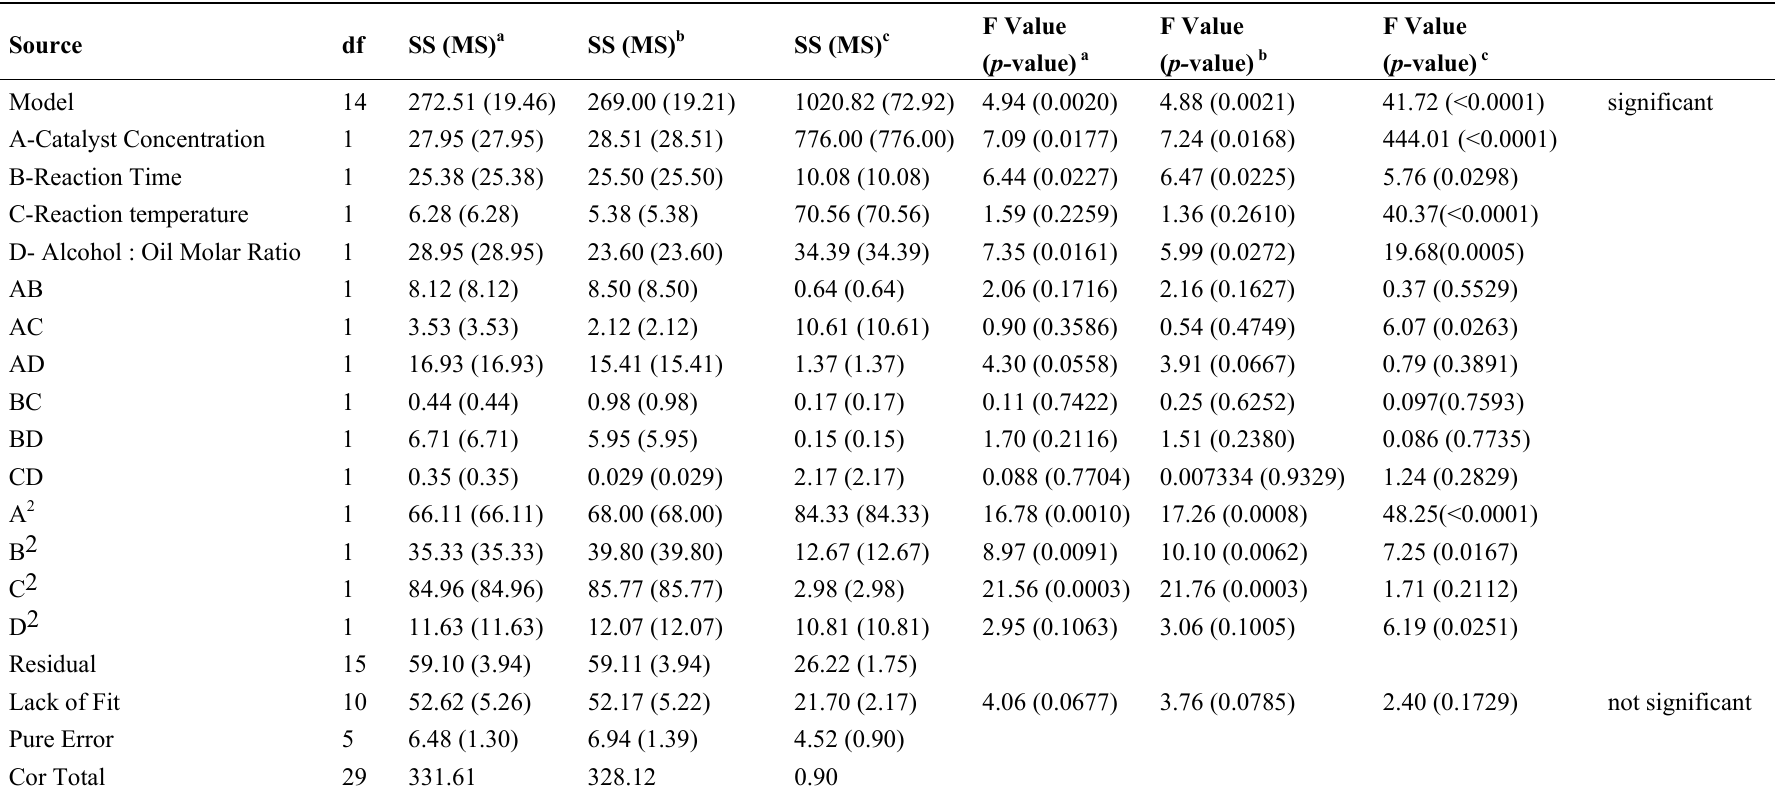
Table 5. Response surface quadratic model analysis of variance (ANOVA) table for chemical transesterification of sunflower